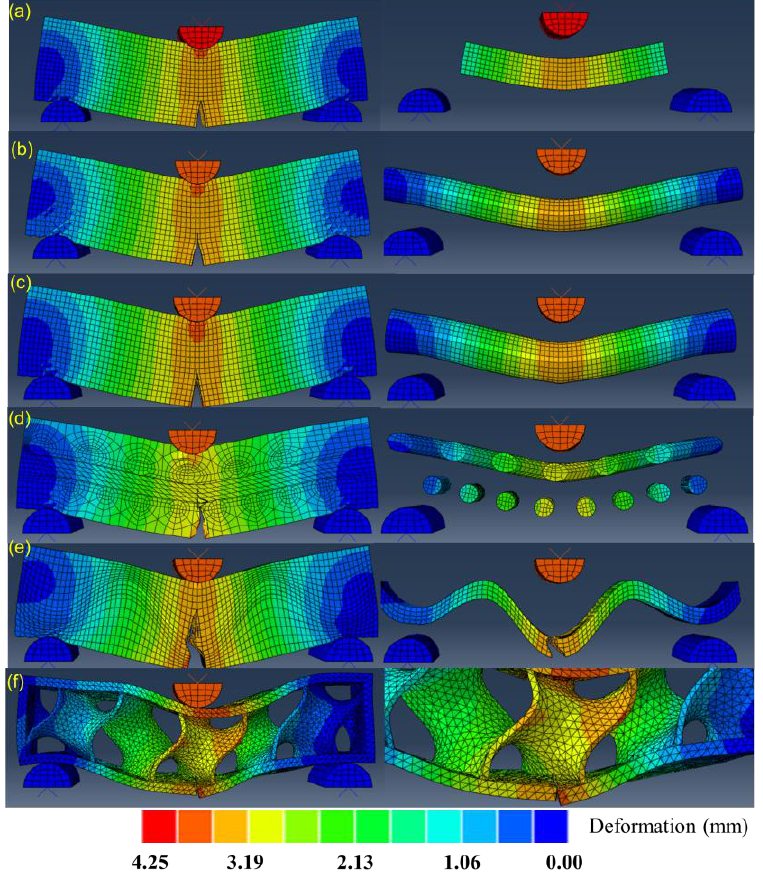
Figure 14. Simulations of crack propagations of the six bionic models ( a ) Layered ( b ) Columnar ( c ) Tubular ( d ) Helical ( e ) Sutured ( f ) Sandwich.